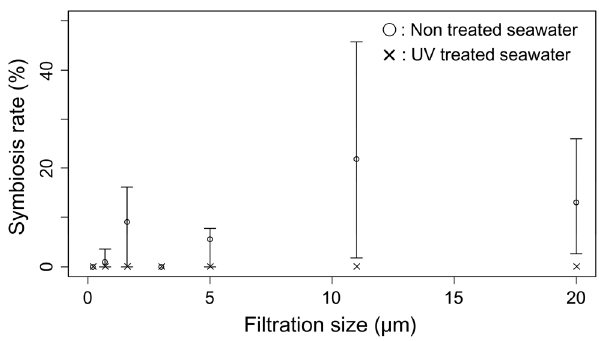
Figure 2. Symbiosis rates of Tridacna crocea in the UV treatment experiment. Showing what percentage of the seeds reared in UV treated and non UV treated seawater filtered at 7 levels established a symbiotic relationship with Symbiodinium. Presented with the mean (circle and cross) and range (vertical line).